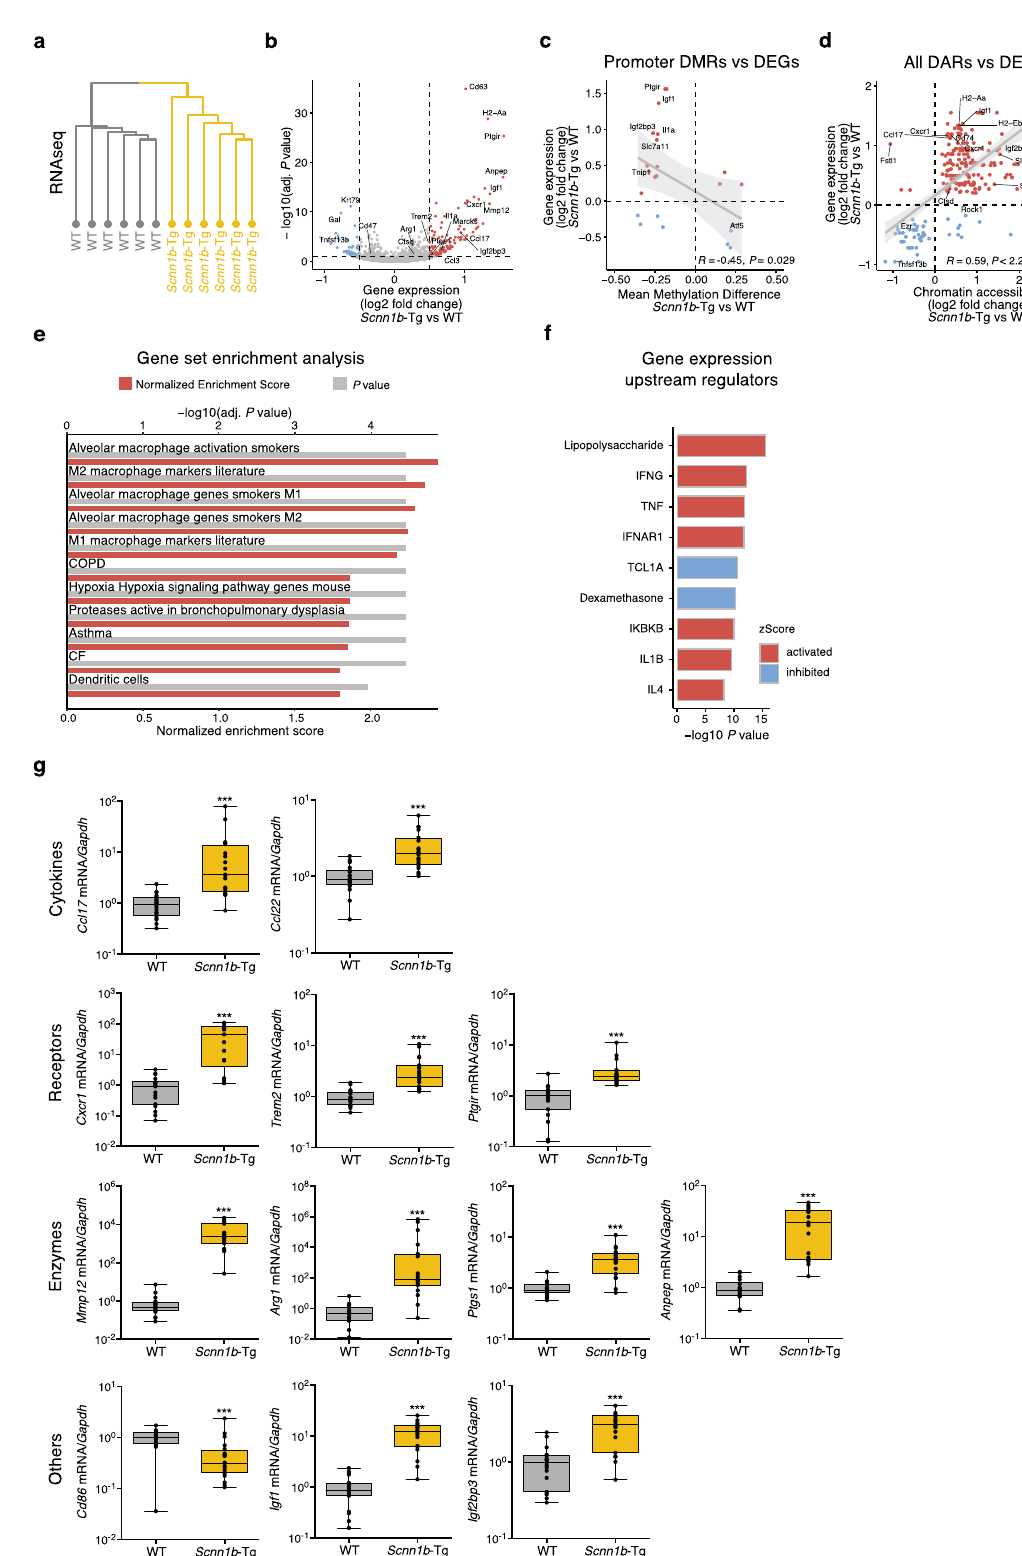
CLEC7A, and CD68 on Scnn1b -Tg compared to WT AMs (Fig. 3b), validating the enhanced activation of AMs in muco- obstructive